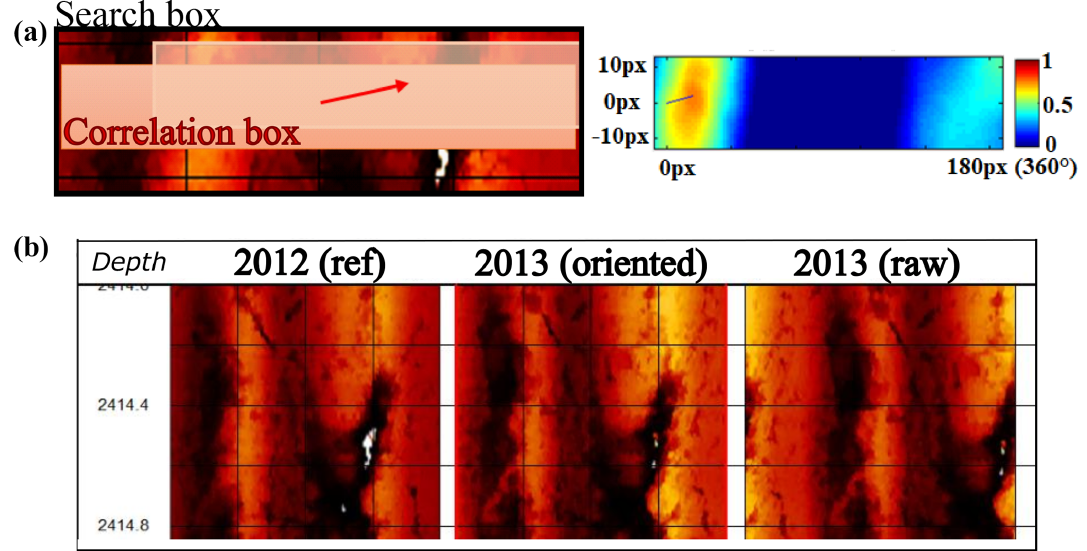
Figure 4. (a) Sketch presenting the process used to orient the images of GRT-1. A correlation box is defined in the double transit time image of reference (acquired in 2012) and is progressively shifted in the image to compare with (red windows) within the limits of the search box (black window). We compute the correlation between the correlation box in its initial position in the image of reference and the shifted correlation box in the image to compare with for each position (right insert). The displacement maximizing the correlation factor enables, at a given depth, us to rotate and adapt the image of 2013 and 2015 according to the image of 2012. (b) Example of original and reoriented time transit images of 2013 at a depth of 2414m (TVD) in